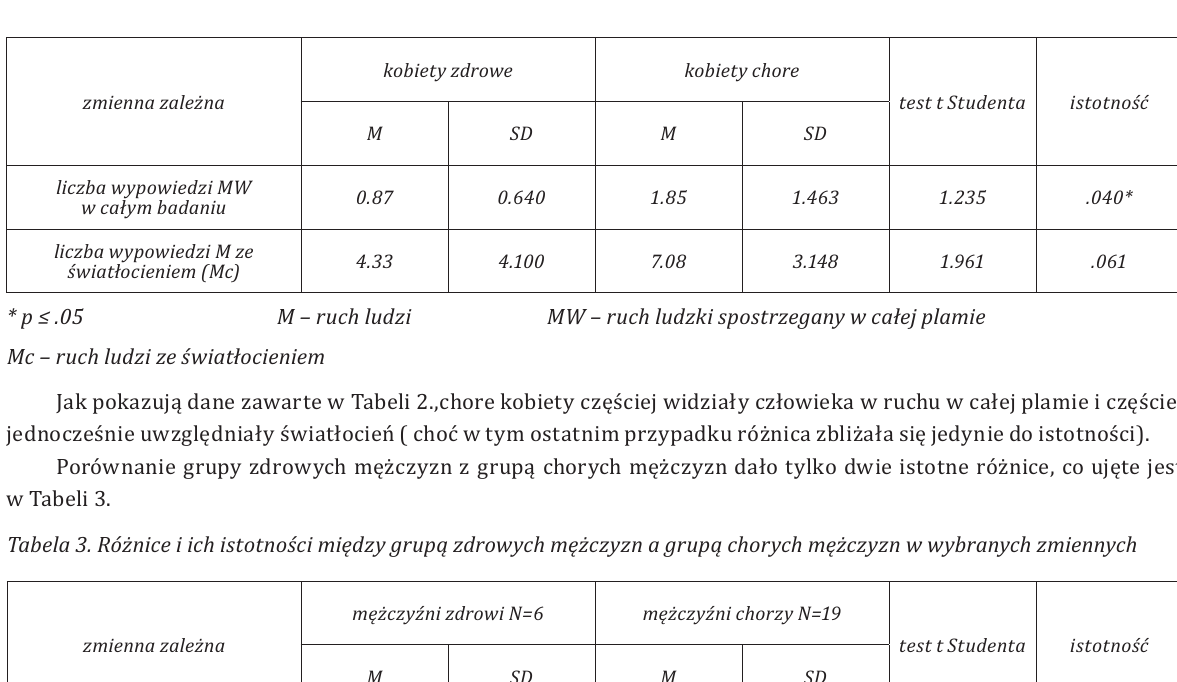
Tabela 2. Porównanie grupy zdrowych kobiet i grupy chorych kobiet pod względem wybranych zmiennych dotyczących